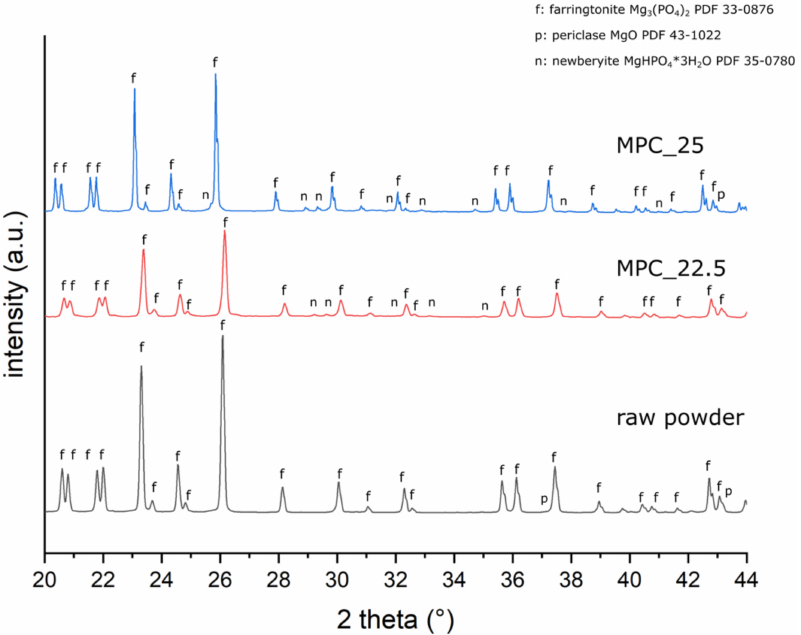
Figure 5. XRD patterns of the cement raw powder and of grind powder of MPC_25 and MPC_22.5 after 3 h of setting. Distinctive peaks are marked with f = farringtonite; n = newberyite; and p =